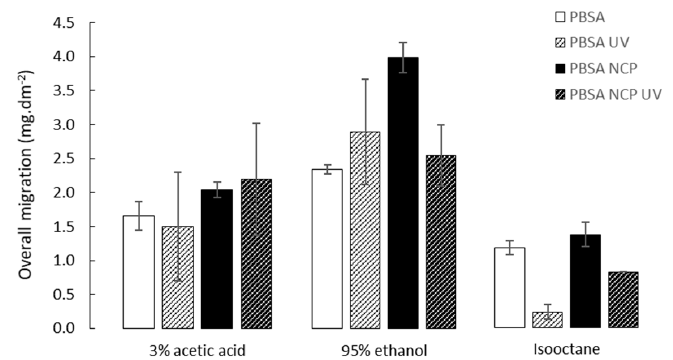
Figure 2. Overall migration of PBSA, PBSA NCP and the corresponding aged materials to the selected food simulants (3% acetic acid, 95% ethanol and isooctane).